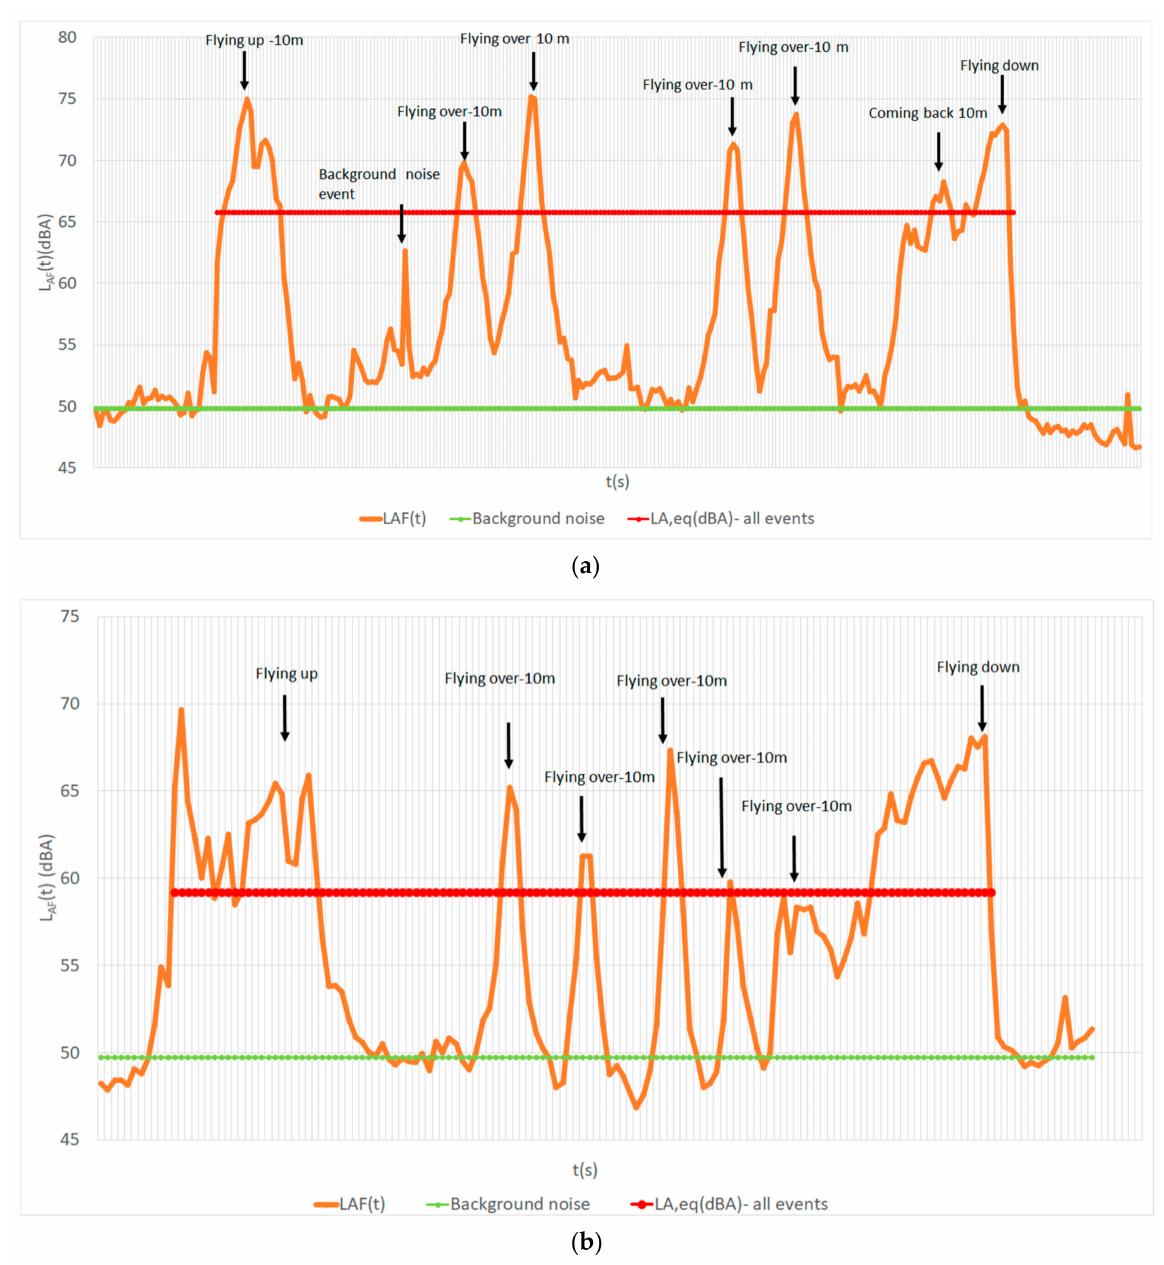
Figure 4. The measurement signals for flying-over procedures for: ( a ) hexarotor; ( b ) quadrotor. The equivalent sound pressure level was determined for all individual events of interest (flying up, flying down, flying over). The correction due to background noise was implemented on the measured overall equivalent sound pressure level, and the average time of events was determined. Furthermore, sound exposure level (L AE or SEL) was calculated for each sound event by knowing the number of events and corrected equivalent sound pressure level of all considered